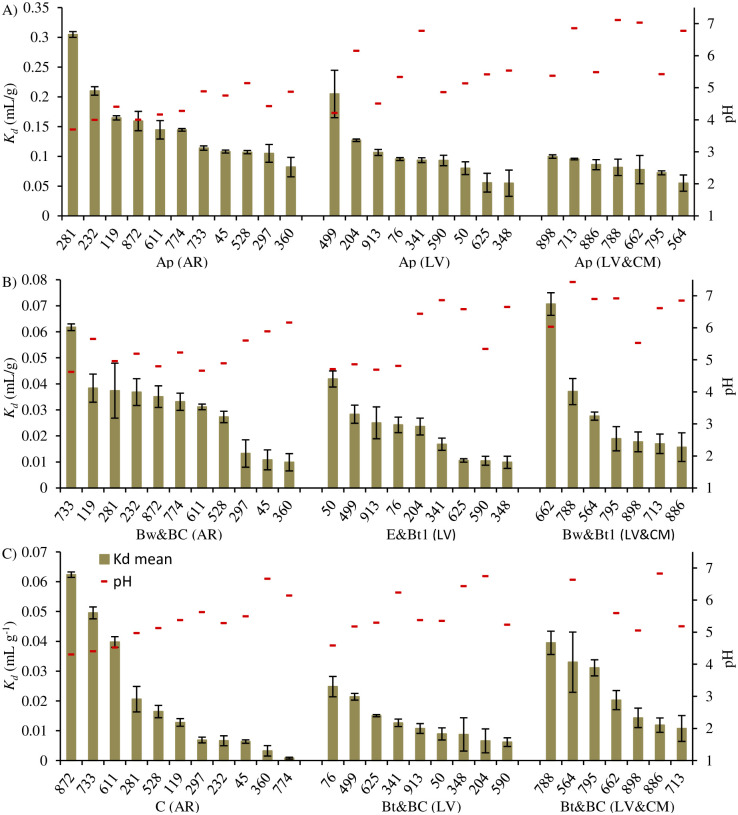
Values of Kd and pH in the soil suspensions in the topsoil (A) and subsoils (B-C) of the examined Arenosol (AR), Luvisol (LV), and Luvisol and Cambisol (LV&CM) profiles.Error bars denote ±SD.